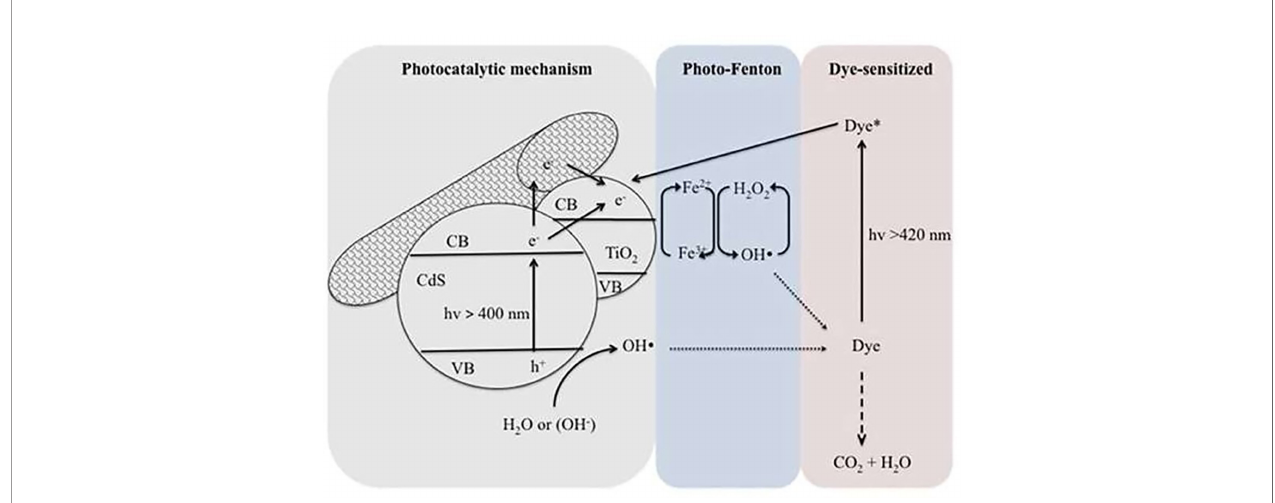
FIGURE 5 | Proposed mechanism of CdS/CNT-TiO 2 /photo-Fenton degradation of methylene blue under visible light irradiation. Reproduced with permission (Kim and Kan,